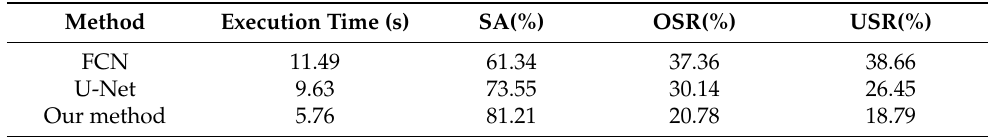
Figure 7. Lesion segmentation results based on different algorithms. Table 3. Algorithm performance comparisons